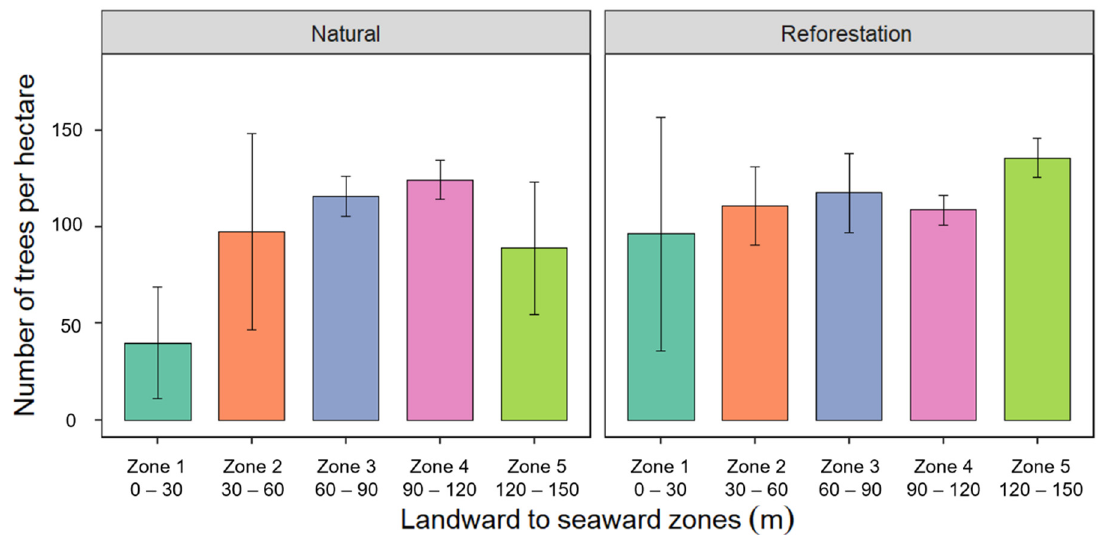
Figure 5. Tree density distribution from landward to seaward in the natural mangrove stand ( left panel) and reforestation site ( right panel). Both panels were displayed in colored bar plots based on the number of trees per hectare.